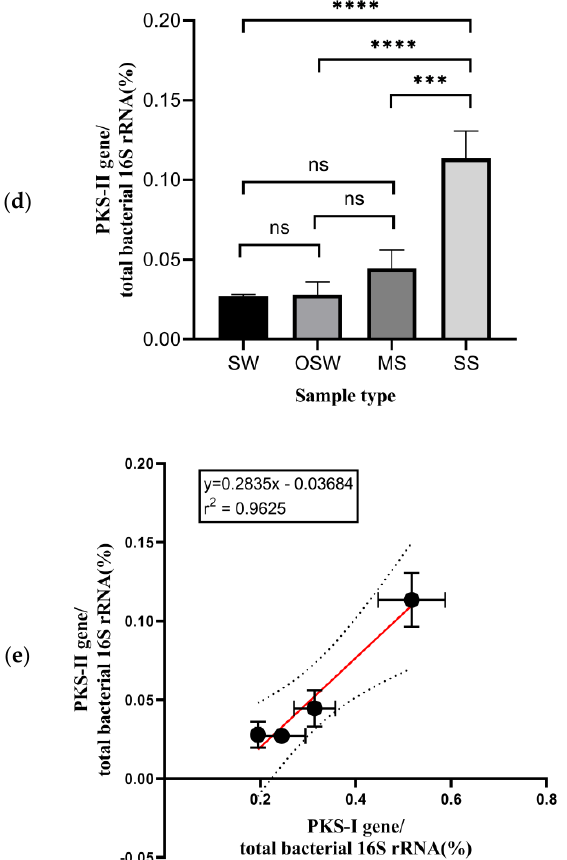
Figure 2. ( a ) Absolute quantification for bacterial 16S rRNA gene copies/gram. ( b ) Relative abun-